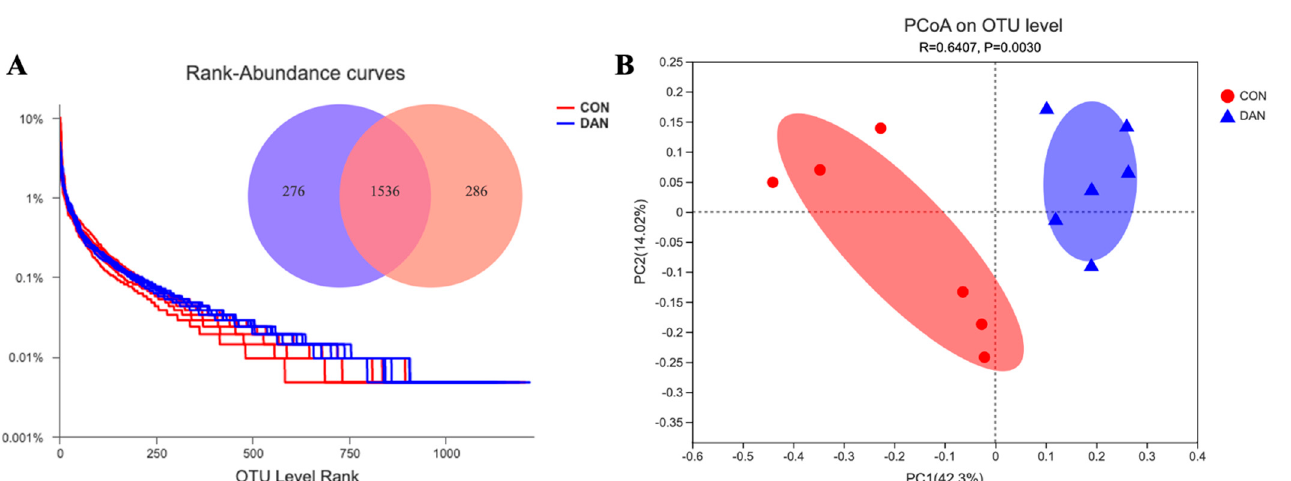
Table 4. Alpha diversity of ruminal bacteria community in mid-lactation dairy cows fed control (CON) and dandelion (DAN) diets.